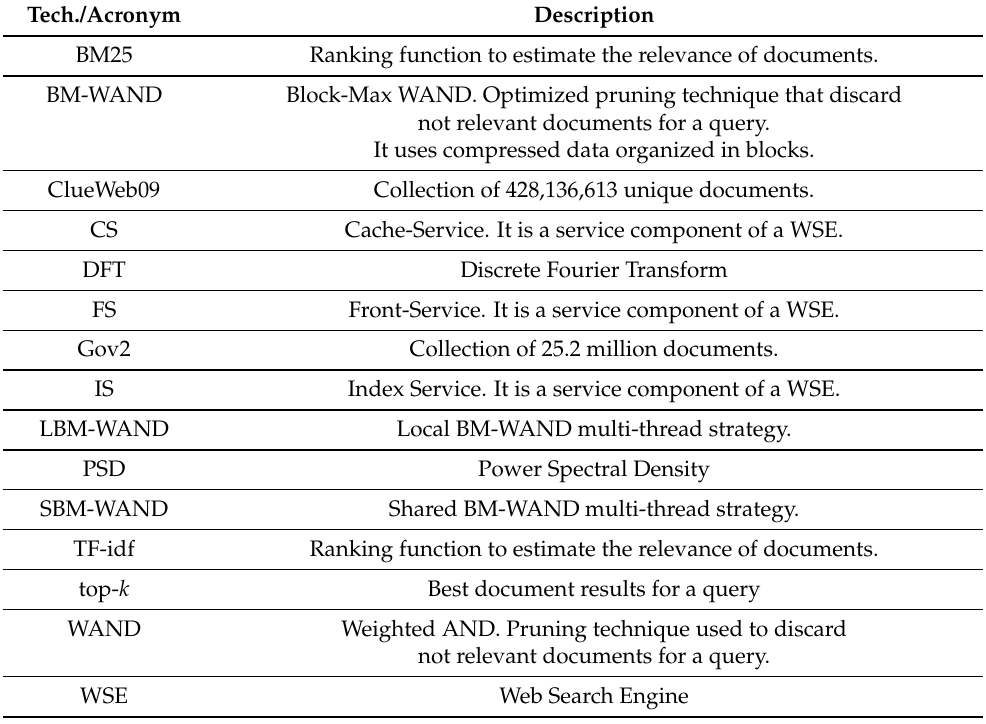
Table 1. Description of the technical